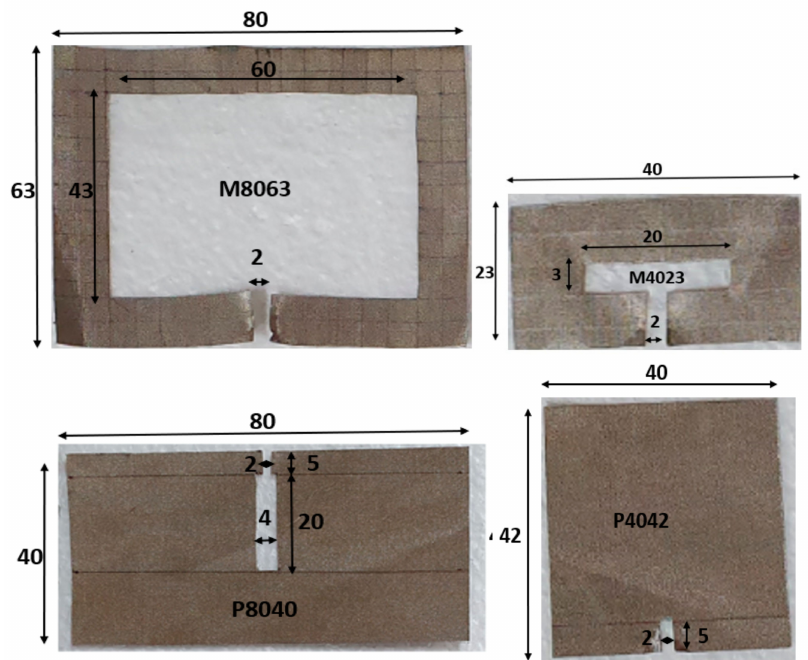
Figure 1. Different shapes and sizes of Adafruit-1168 fabric for impedance and resistance measurement.